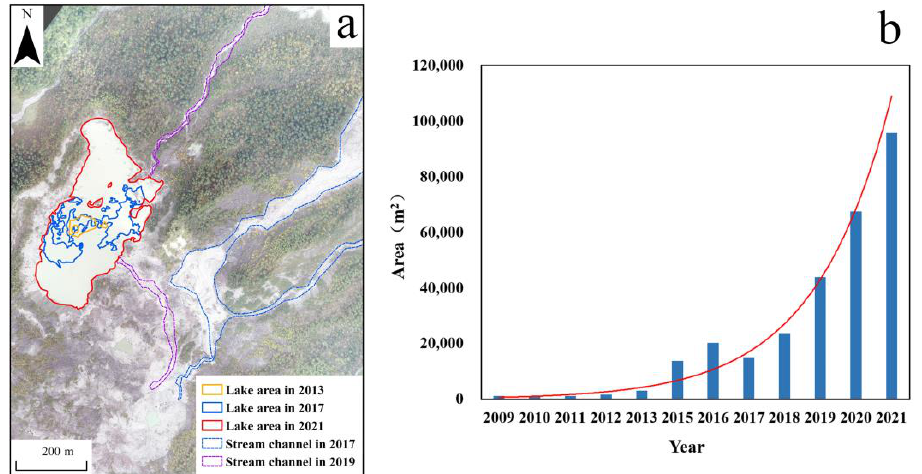
Figure 6. ( a ) The evolution of the moraine-dammed lake at the terminus in 2013, 2017, and 2021, together with the migration of the stream channel in 2017 and 2019. The background image is DOM acquired in 2021. ( b ) The annual lake area and its exponential increasing trend (red line) during the period between 2009 and 2021.